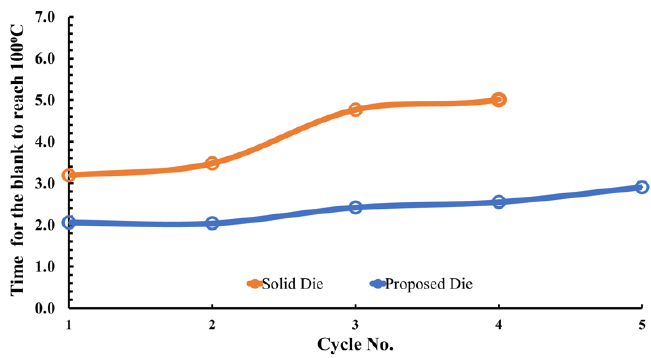
Figure 7. Time for the blank to cool down to 100 ℃ .